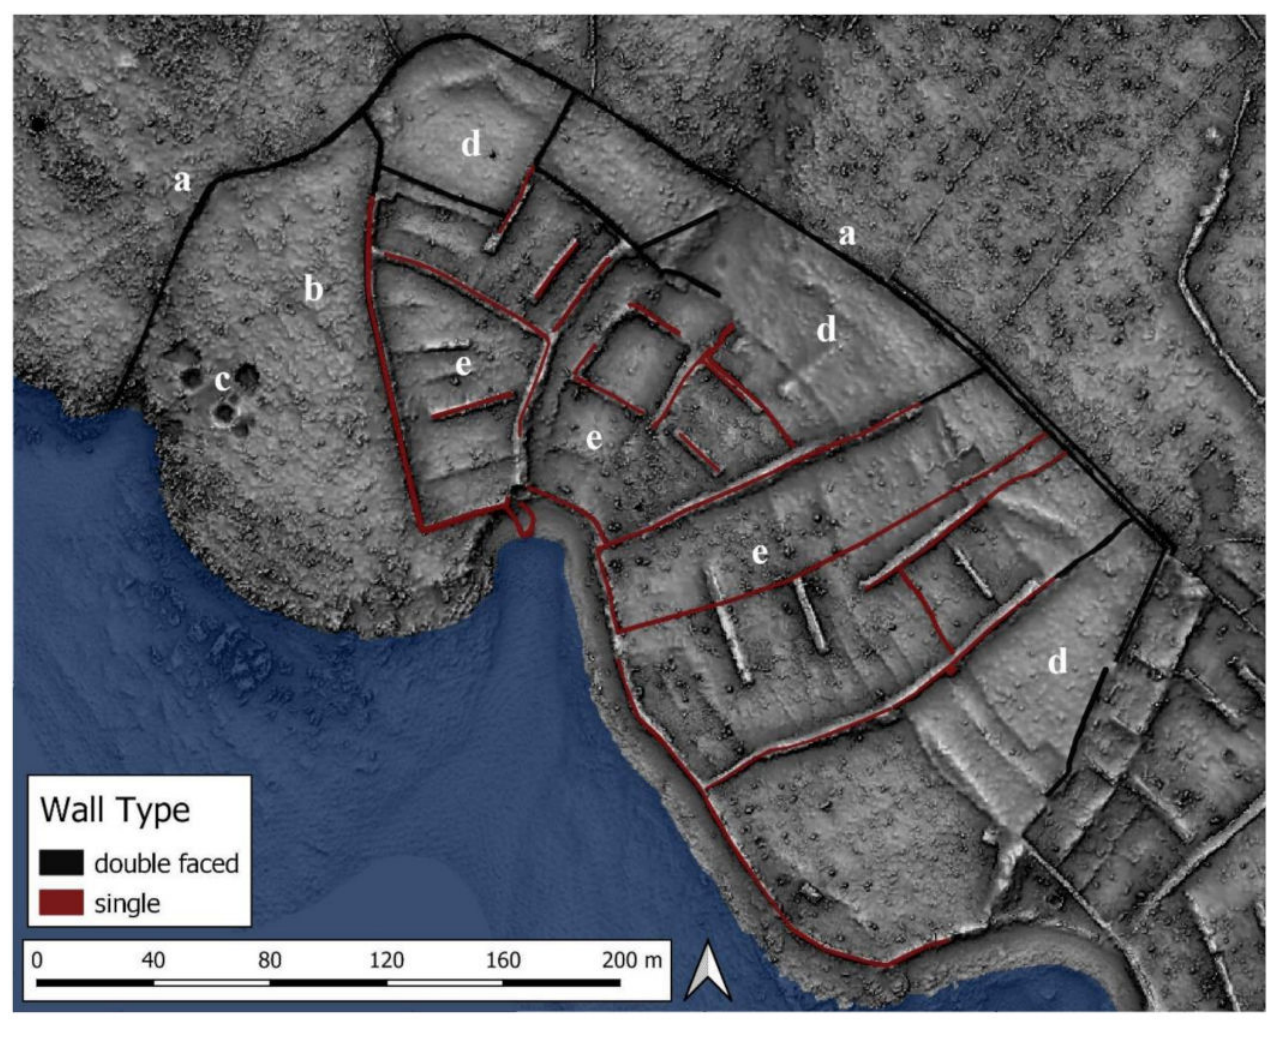
Figure 13. Interpretative map of recent dry stone walls. ( a ) bounding wall, ( b ) area with a rough surface texture containing ( c ) lime kilns, ( d ) area covered with many small and some larger stones, ( e ) area cleared of larger stones (visualization: